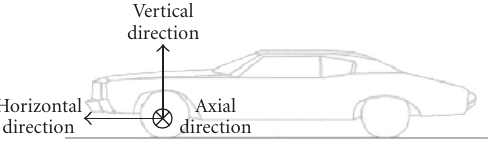
Figure 1: The reference directions.